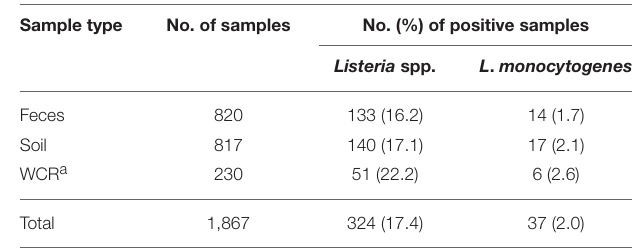
TABLE 3 | Broiler cold storage procedures before making the product available for consumers for each farm. Farm Storage temperature ( ◦ C)